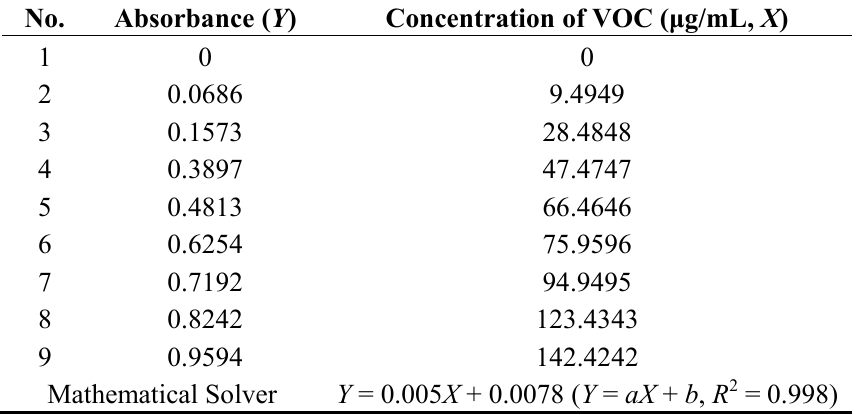
Table 4. Relationship between the absorbance and concentration of VOC